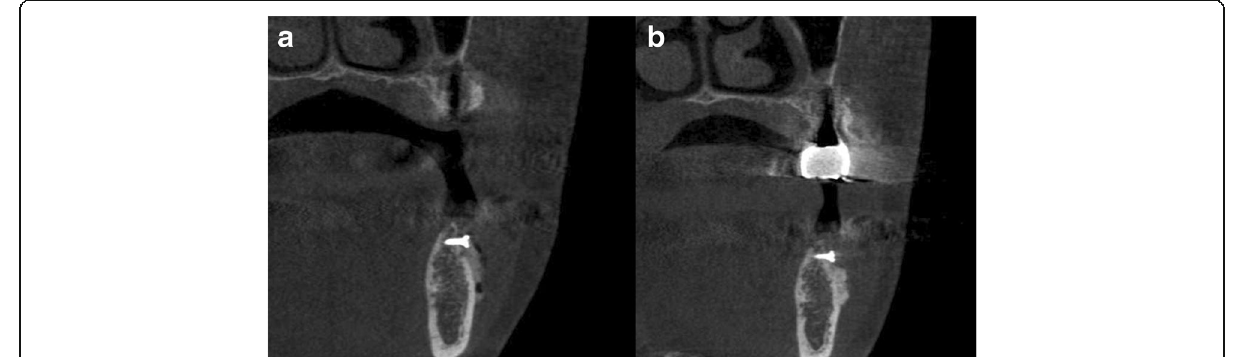
Fig. 2 CBCT, postoperative view. a Immediately after the bone graft. b Four months after the graft